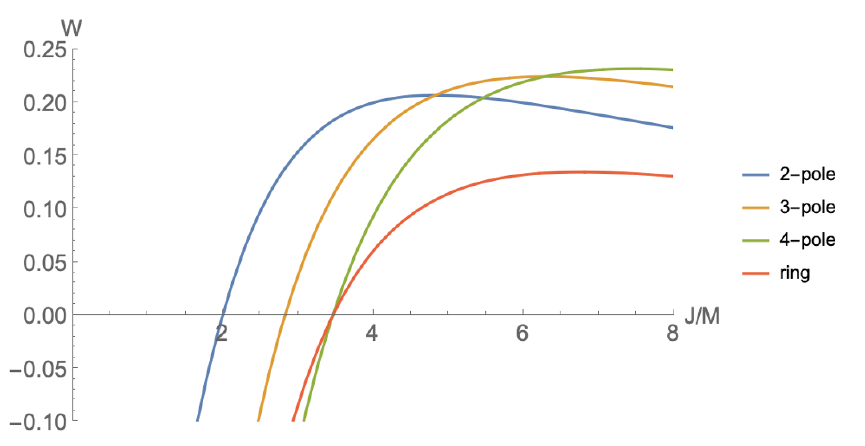
Figure 3 . Phase diagram of MP black holes (blue line) and black bars (black line). Red dots indicate the presence of non-axisymmetric marginal modes. Black circles indicate axisymmetric marginal modes of MP black holes. Observe that marginal modes of MP black holes and black bars appear at the same values of (cid:10) but di(cid:11)erent J=M . (Reproduced from [2])